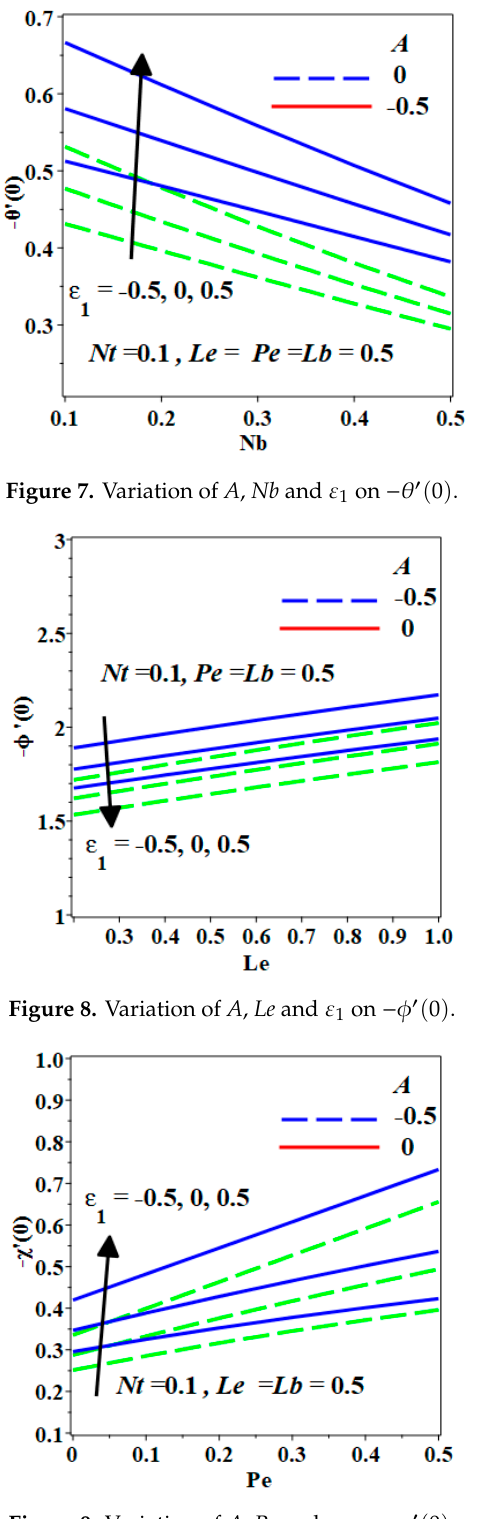
Figure 9. Variation of A , Pe and ε 1 on − χ (cid:48) ( 0 )